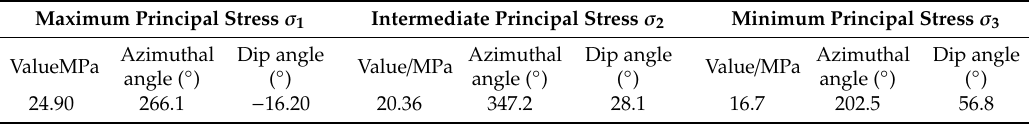
Table 8. Principal stress results for the test points in the PDS No. 11 coal mine.